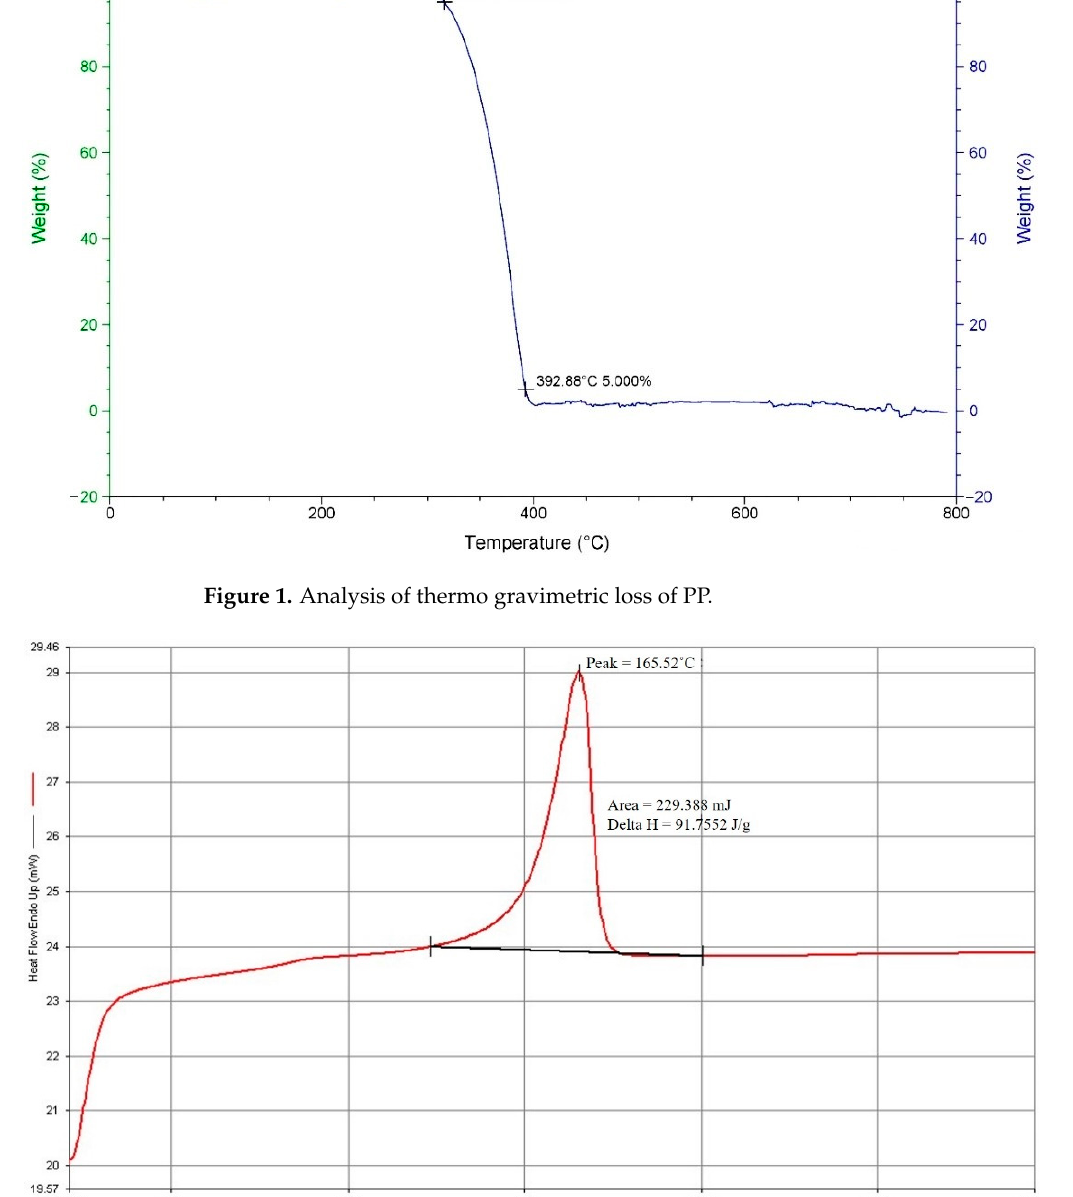
Figure 2. PP melting point.